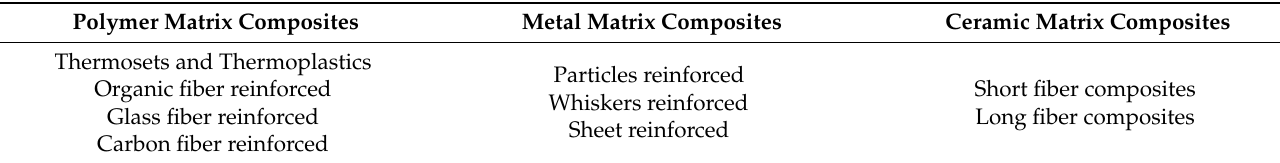
Table 1. Types of